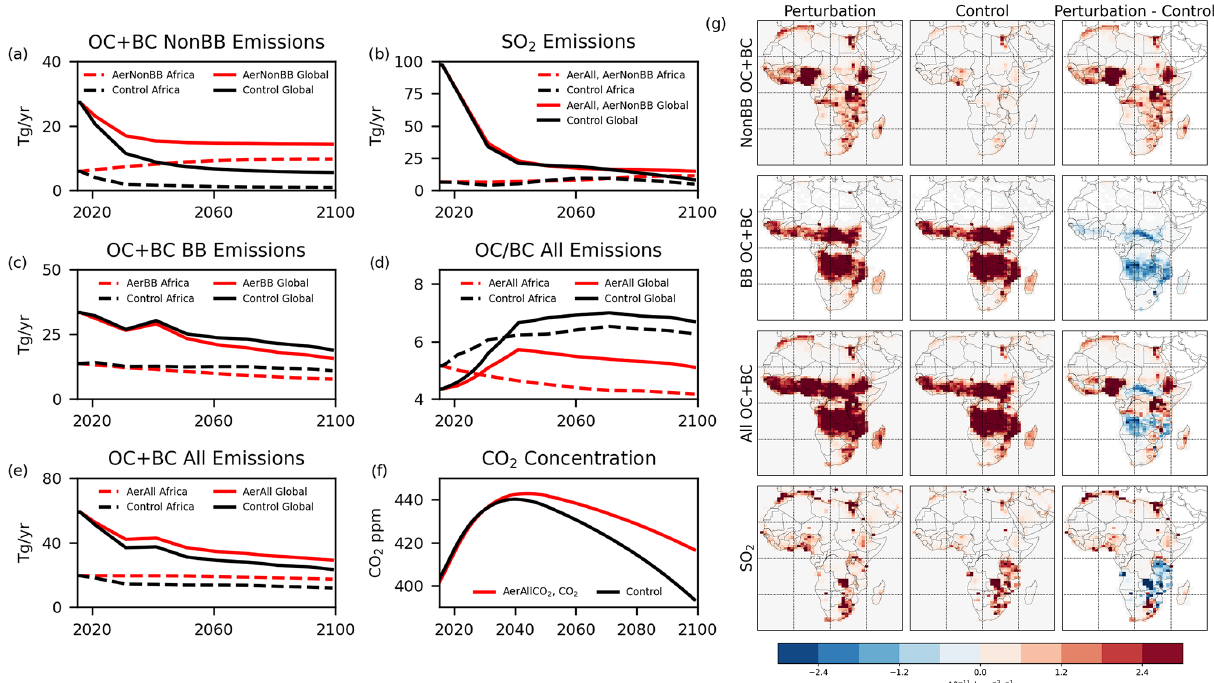
Figure 1. Time series of OC + BC (carbonaceous) aerosol, from non-BB (a) , BB (c) , and their sum (e) , as well as SO 2 emissions (b) and the OC / BC ratio for total emissions (d) . These emission time series are shown globally and over Africa for OC + BC. CO 2 global concentrations are also indicated (f) . The control experiment follows the black curves, with the changed emissions labelled according to the experiment(s) they relate to. Also shown are maps of aerosol emissions in each scenario, and their difference, in 2060 (g) .